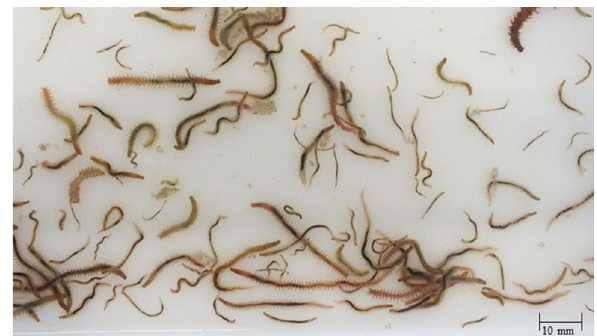
Figure 3. Hediste diversicolor juveniles produced after 120 days of culture.